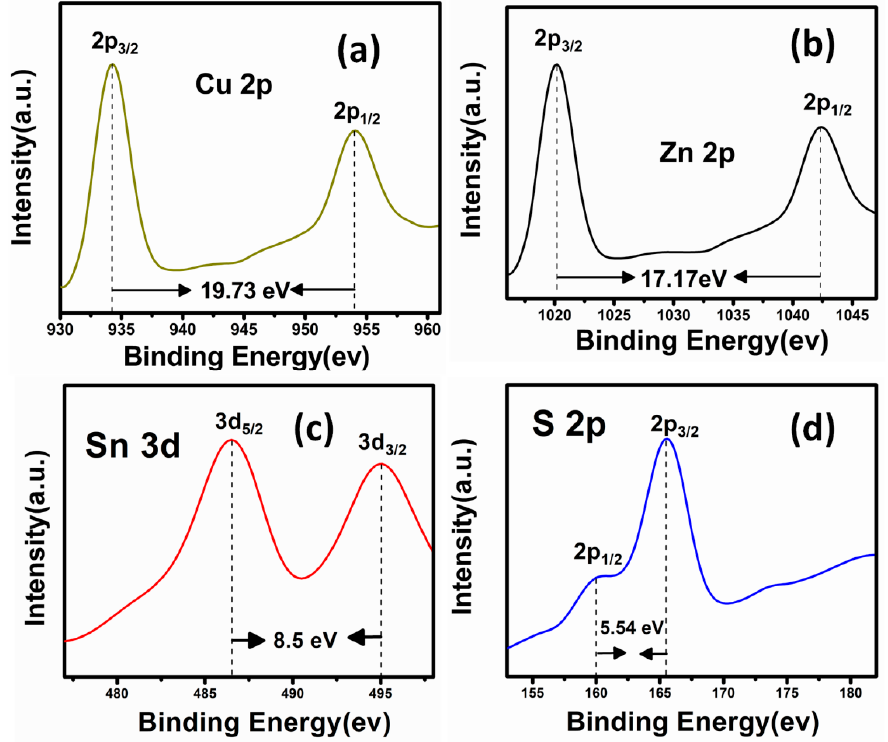
Figure 6. X-ray photoelectron spectroscopy (XPS) core level spectrum of ( a ) Cu 2p, ( b ) Zn 2p, ( c ) Sn 2p, and ( d ) S 2p peaks measured for an atypical CZTS thin film prepared using 20 mg/mL of 1,8-diiodooctane